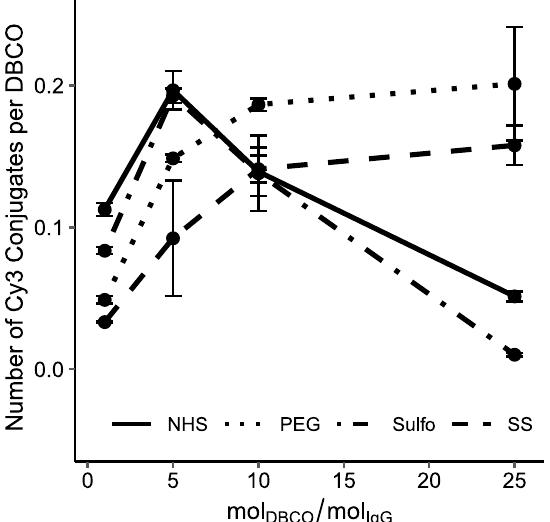
Figure 1. Click reaction yield in dependence of the molar ratio of DBCO-NHS to antibody used for the functionalization of the antibody. The average number of DBCO and Cy3 groups was determined by measuring the absorbance at 309 nm and 554 nm, respectively. After antibody functionalization, Cy3-azide was added at a 50 molar excess to saturate all functional DBCO groups. At a molar excess of about 5 to 10 mol DBCO per mol antibody, the reaction shows the highest conjugation yield in the subsequent click chemistry reaction for all tested DBCO derivates. Conjugation reactions with DBCO-Sulfo-NHS and DBCO-NHS with a molar ratio of DBCO to antibody above 5 resulted in protein and/or DBCO precipitation and, thus, a lower reaction yield. Error bars represent the standard